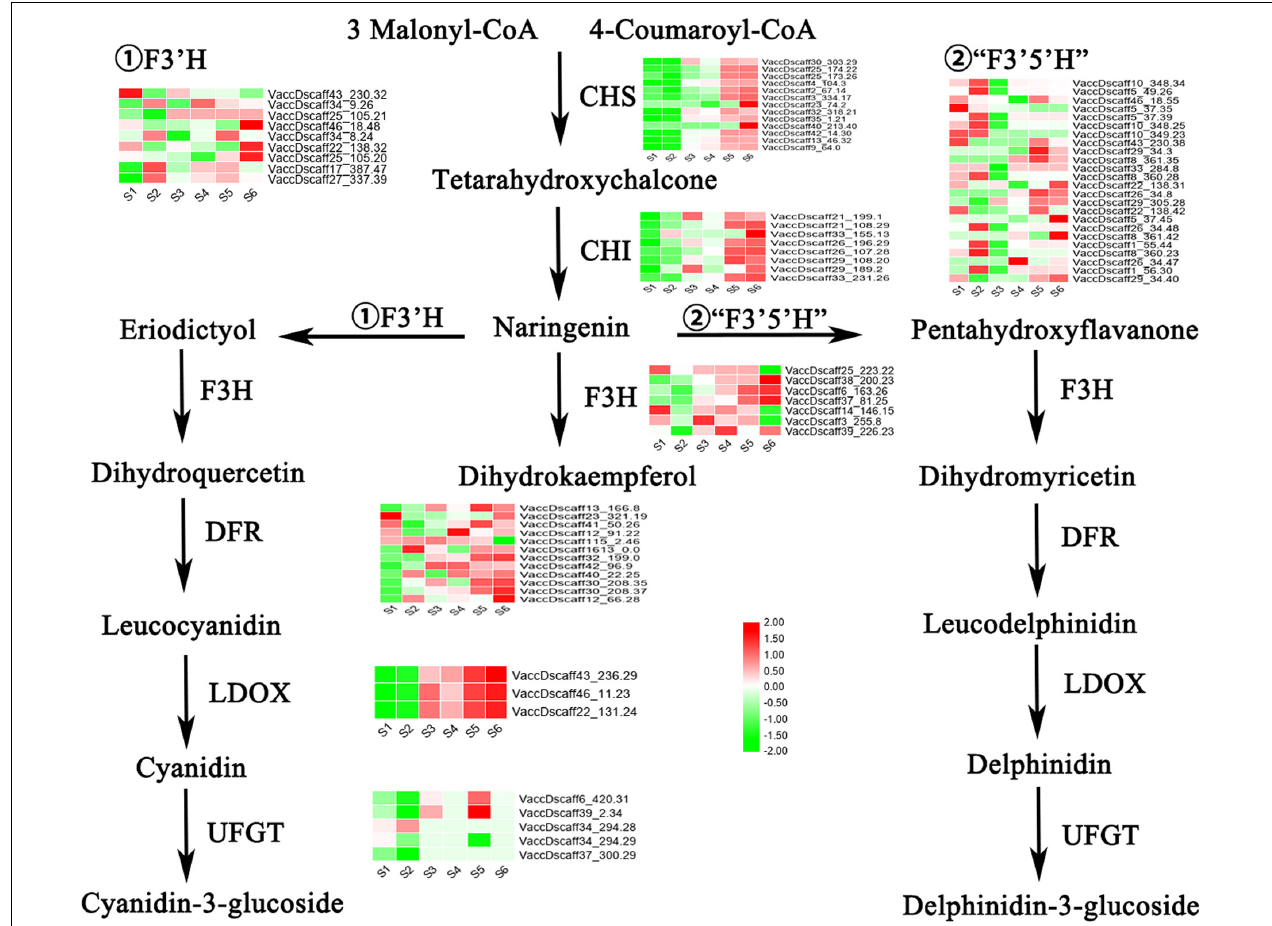
FIGURE 4 | Expression changes of key structural enzymes in anthocyanin pathway during S1–S6 after ABA treatment. Red represents up regulation of gene expression, while green represents down regulation of gene expression. The expression levels (FPKM) corresponding to the different colors ranges from –2 to 2.